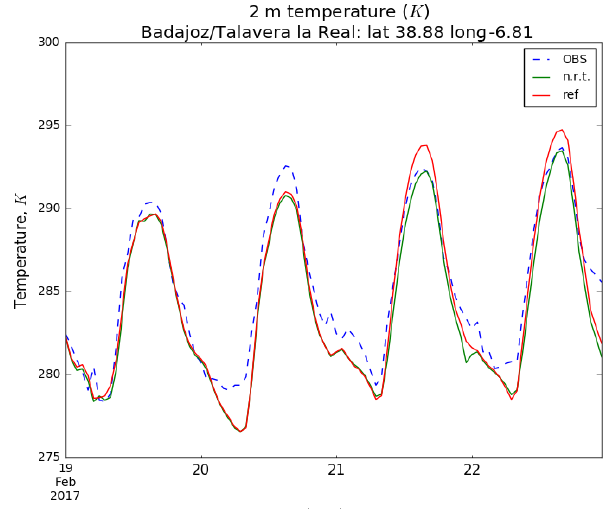
Figure 5. As for Fig. 4 but for the screen-level temperature at the automatic station Talavera la Real,